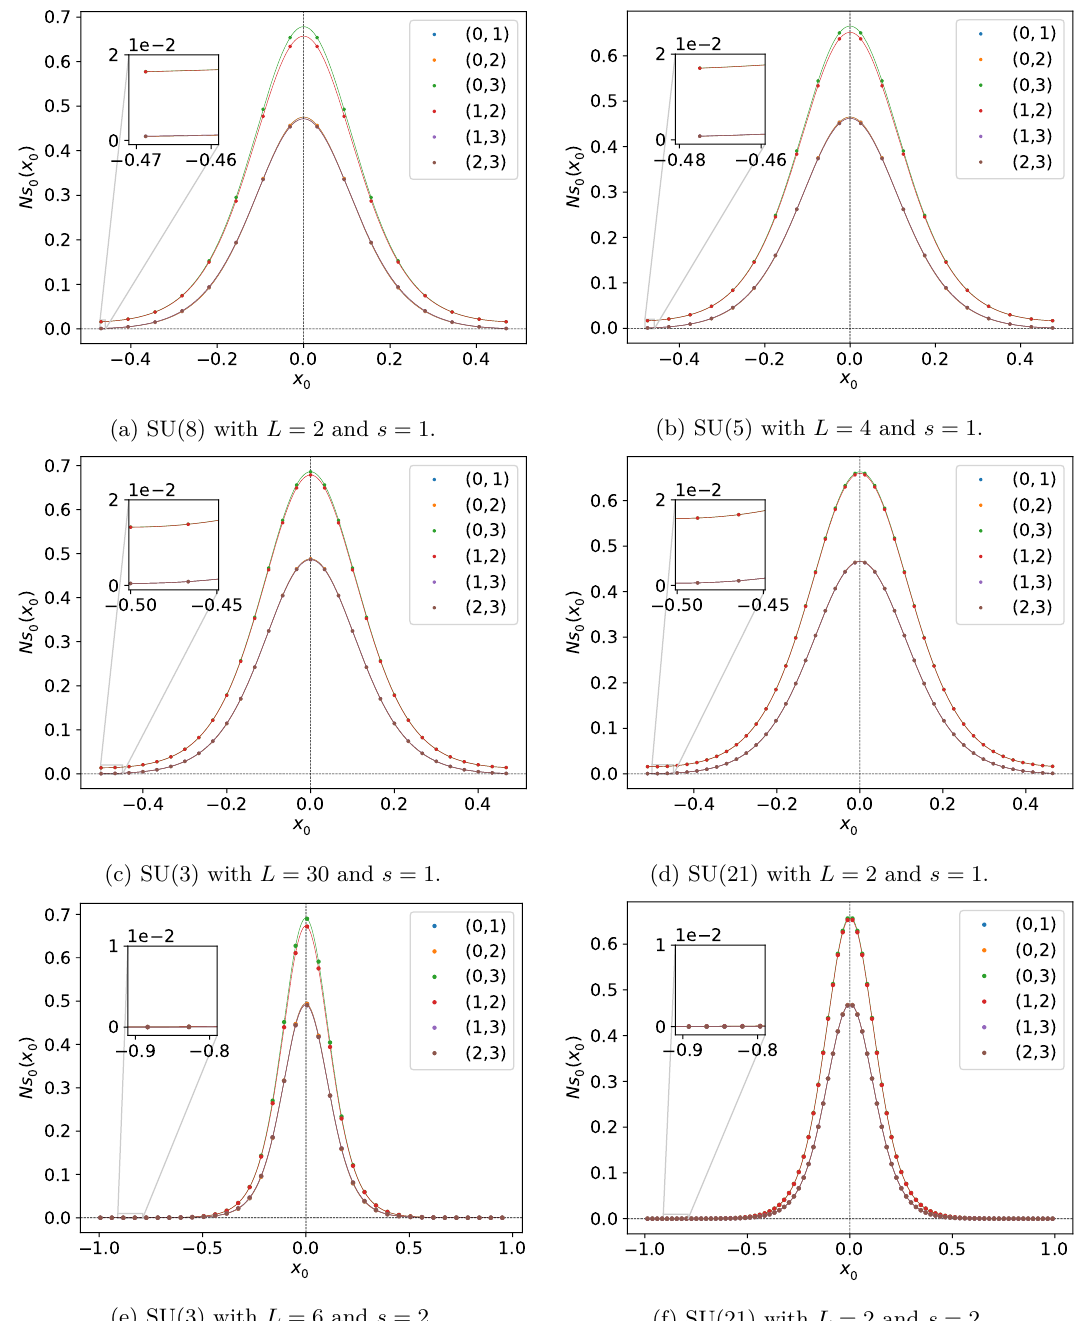
Figure 8. Time dependence of the electric and magnetic components of the energy obtained (cid:1) with ( by integrating Tr (cid:0) F 2 µ , ν ) fixed, over the three spatial coordinates. The two largest µν components are 03 and 12. Components 01 and 02 are, to a very good degree, degenerate and the same happens to 23 and